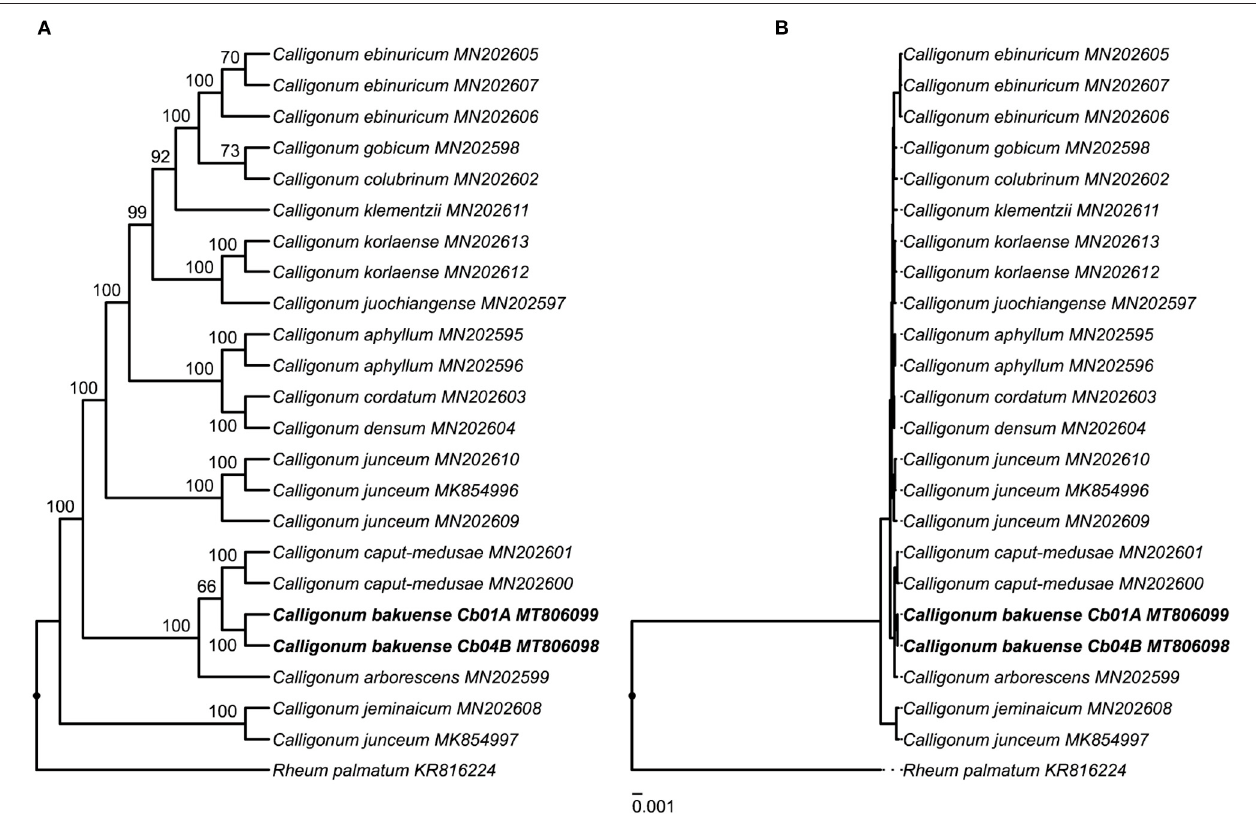
FIGURE 6 | Phylogenetic position of C. bakuense among other species of Calligonum . C. bakuense is represented by the final plastid genomes of individuals Cb01A and Cb04B, which are highlighted in bold. The displayed phylogenetic tree represents the best tree inferred under ML, visualized as (A) cladogram with bootstrap node support (given above branches) and (B) the corresponding phylogram with exact branch